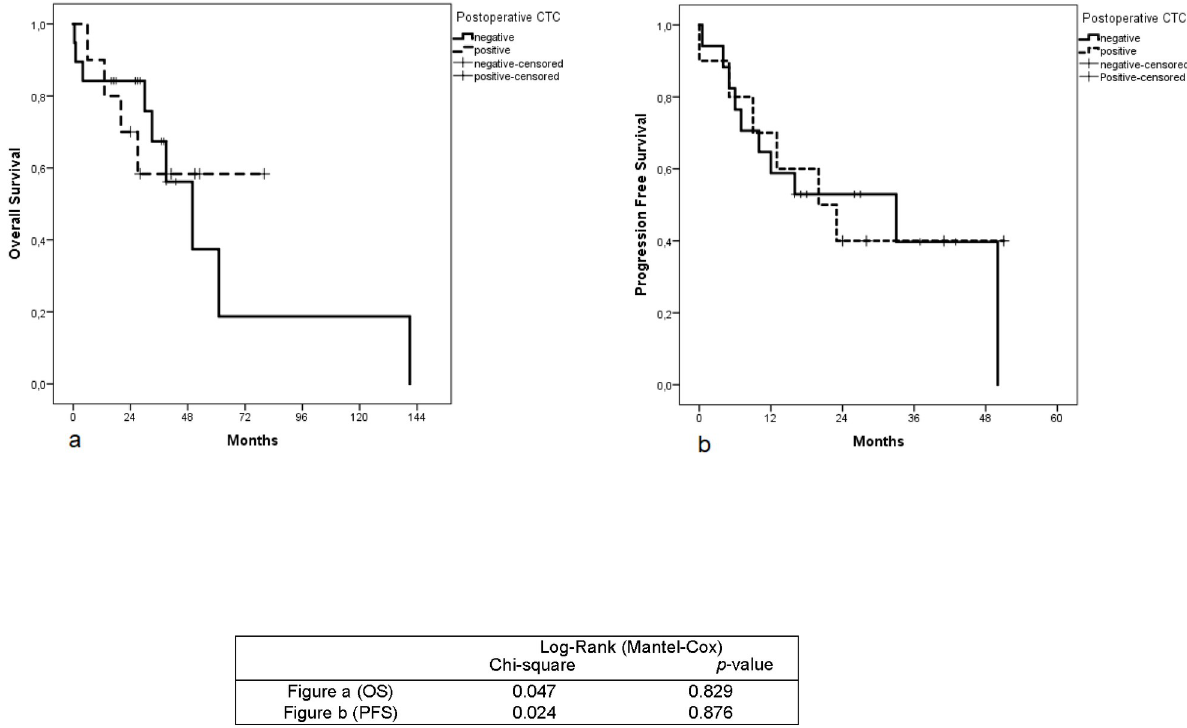
Fig 4. Kaplan-Meier analysis for overall survival and progression-free survival according to the postoperative CTCs. Fig (a): Overall survival in patients with CRC, positive vs. negative postoperative CTCs. Fig (b): Progression-free survival in patients with CRC, positive vs. negative postoperative CTCs. P -value Indicates significance according to Log-Rank (Mantel-Cox) test when CTC-negative patients are compared with CTC- positive patients postoperatively.